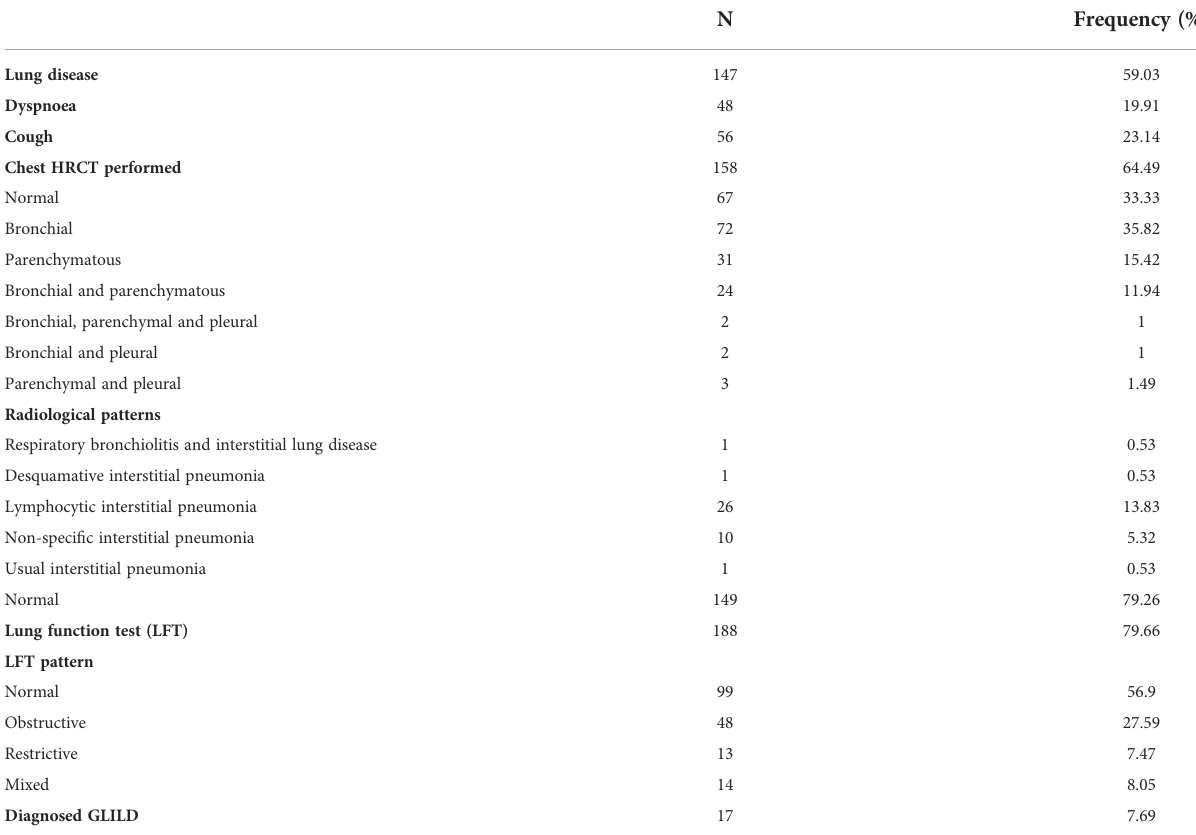
TABLE 5 Lung disease in the GTEM-SEMI-CVID